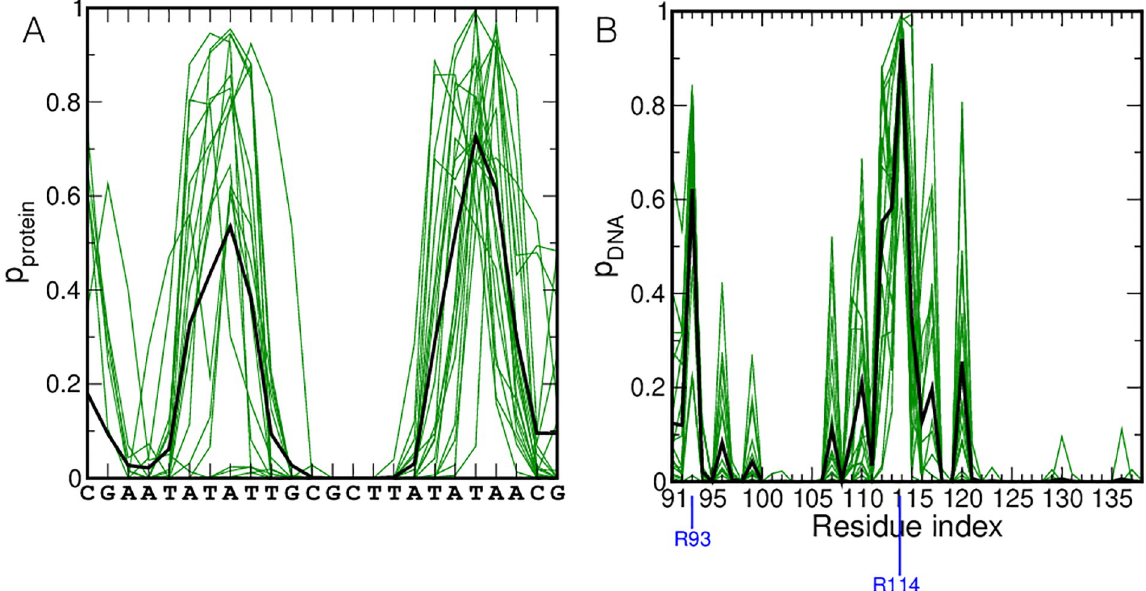
Fig 2. Proximity of H-NS and DNA. (A) The probability of finding the protein within a minimum distance of 0.6 nm of the DNA is plotted as a function of the nucleotide sequence. (B) The probability of finding the DNA within a minimum distance of 0.6 nm of the protein is plotted as a function of the amino acid sequence. The green lines indicate the probabilities for the individual trajectories, the black line indicates the average over all trajectories. Residues R93 and R114 are marked with a blue line.